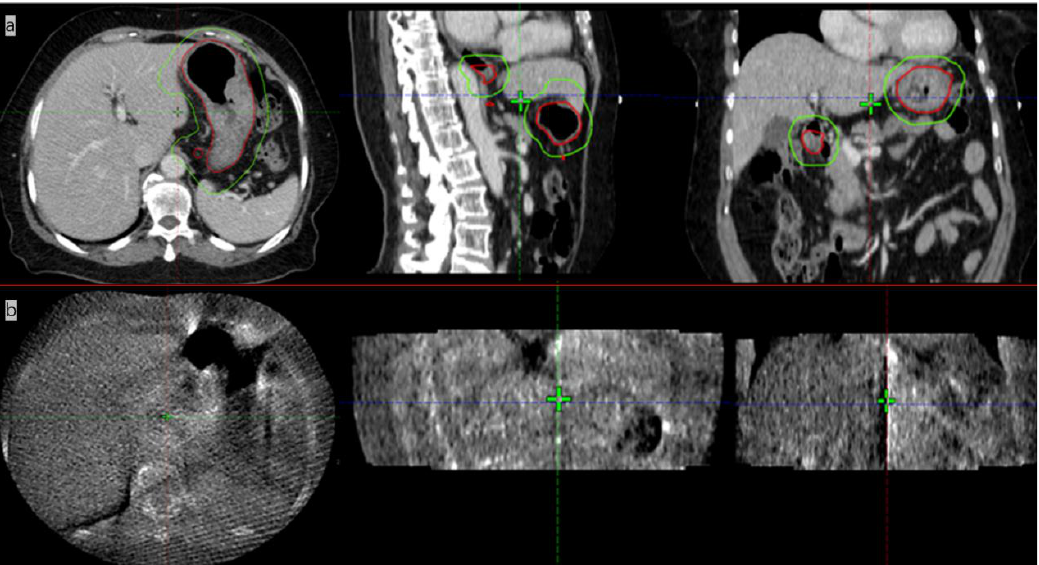
Figure 5. Images of patient #2 with contrast CT simulation ( a ) and CBCT imaging ( b ). The red line in ( a ) shows the stomach, and the green line contours the PTV.